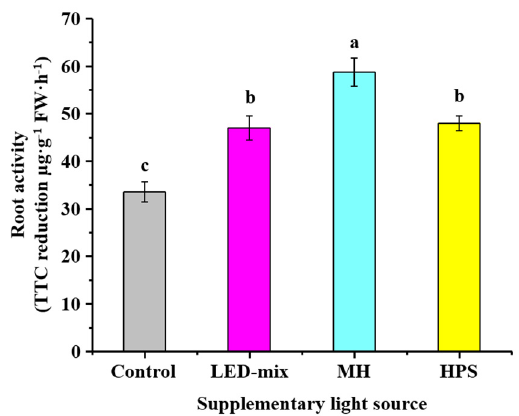
Figure 4. Effect of the supplementary light source on the root activities of carnation ‘Dreambyul’. Data are shown as the mean ± SEs, and different letters on the bars indicate significant differences according to the Duncan’s multiple range test at p ≤ 0.05.